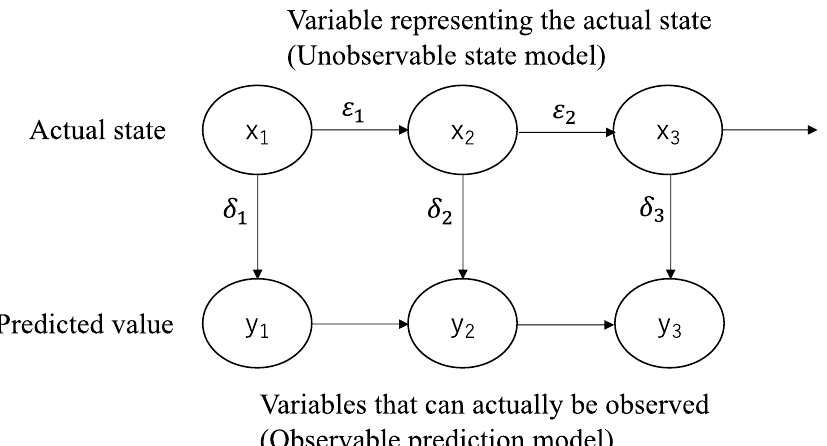
Figure 2. State ‐ space representation (SSR) model. Figure 2. State-space representation (SSR)